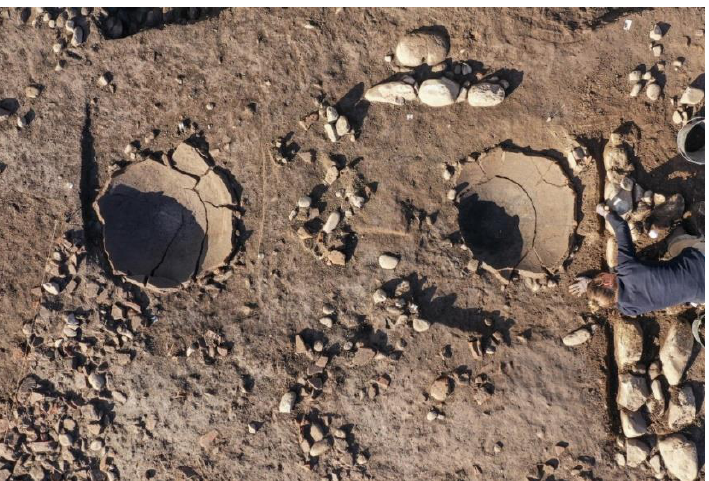
Figure 8. Aerial view of the Chiarata site where the bases of dolia were discovered in 2020 (credits: INRAP). Accurate dating of these archaeological vessels used for the storage of goods has not yet been defined, but they can reasonably be attributed to the second half of Roman times. The existence of these earthenware storage containers supports pollen investigations indicating cereal cultivation during Late Roman times.